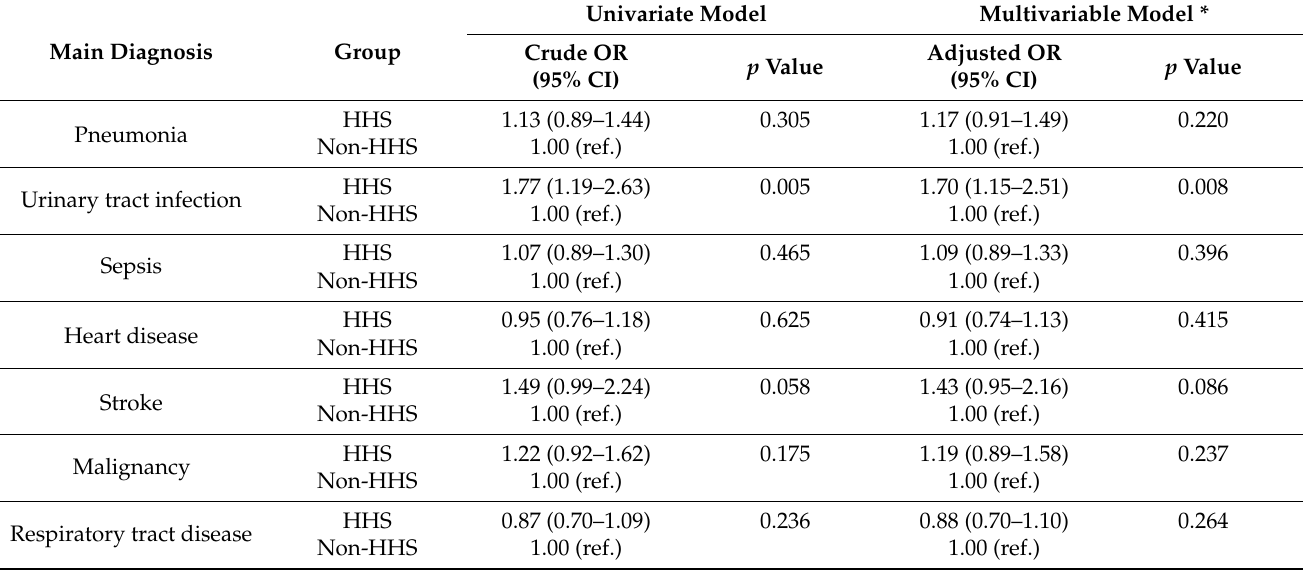
Table 5. Odds ratio of VTE in HHS versus non-HHS admissions based on different admission